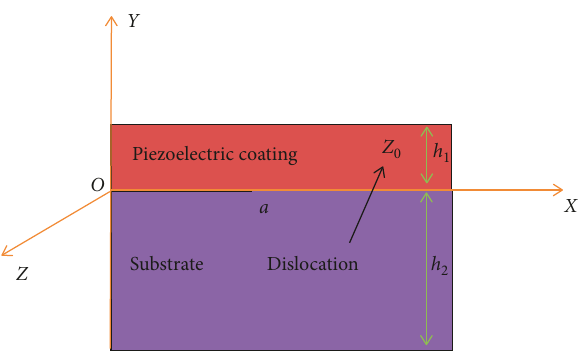
Figure 1: The fine-grained piezoelectric coating/substrate